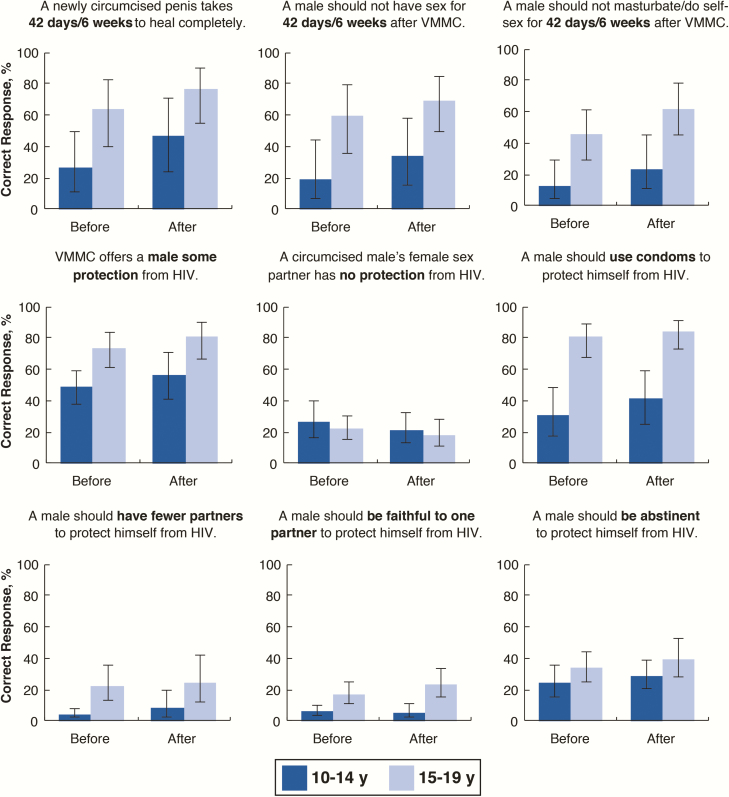
Voluntary medical male circumcision (VMMC) postprocedure care and human immunodeficiency virus (HIV) prevention knowledge before and after VMMC counseling, by age group. Bars represent the percent correctly answering a given question. Data are limited to complete cases who had available data in the pre- and post-procedure surveys. Error bars represent design-based 95% confidence intervals as estimated by Taylor series linearization and account for clustering at the facility level.